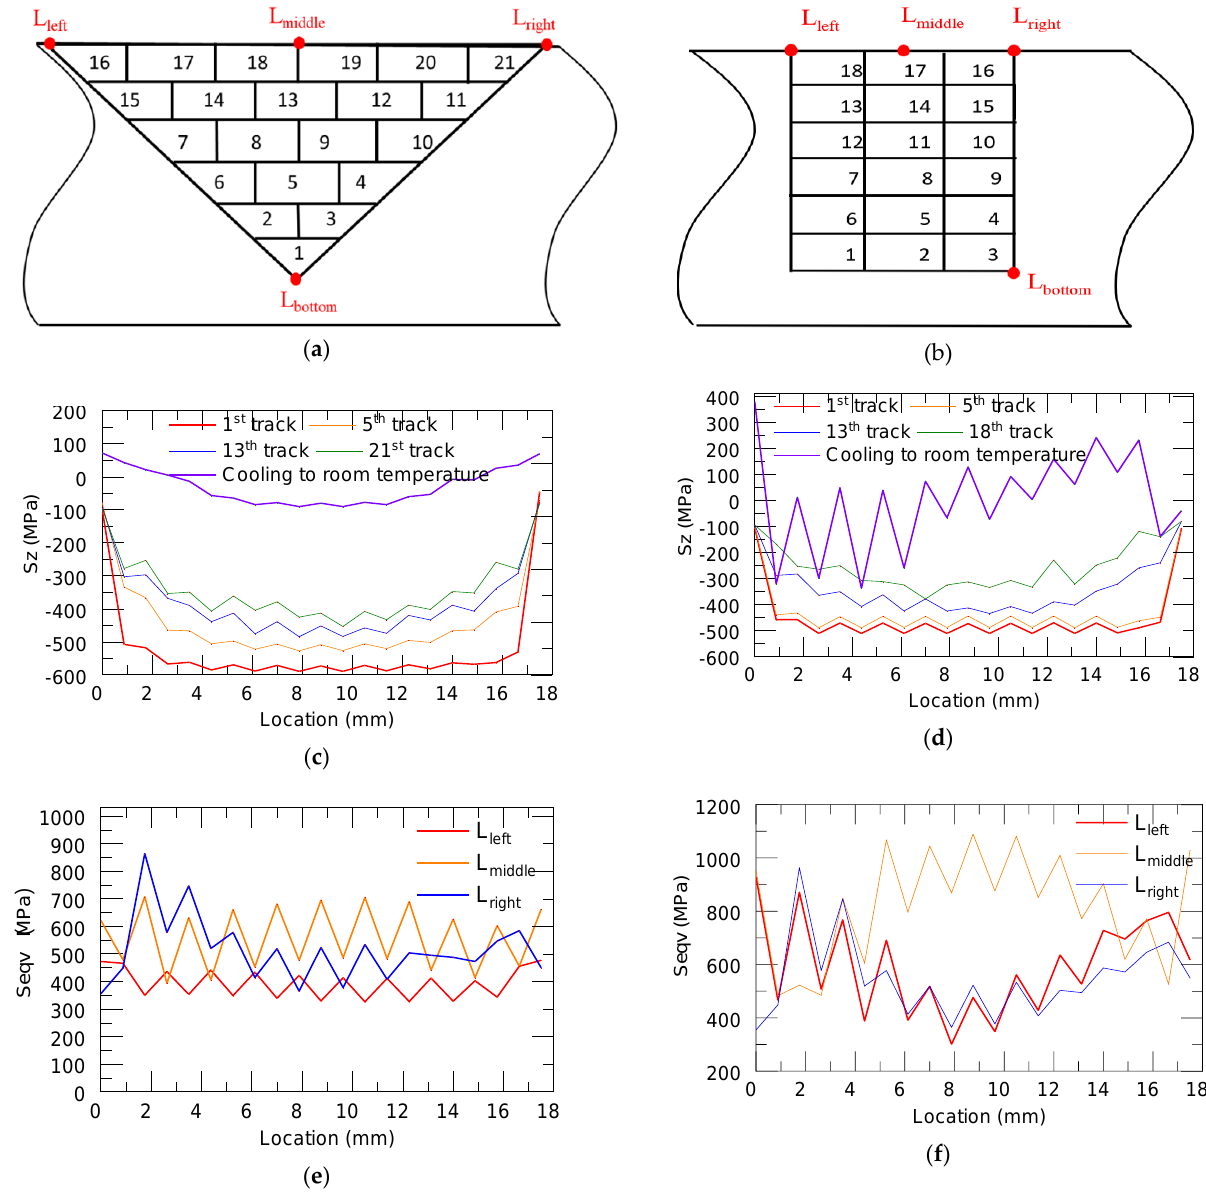
Figure 11. Schematic showing the definition of L left , L right , L middle , and L bottom for the triangular ( a ) and rectangular ( b ) case; longitudinal residual stress distribution along the interface line after the deposition of 1 st , 5 th , 13 th , and last layers in the triangular ( c ) and rectangular ( d ) repair cases; Von Mises stress distributions along three lines in the triangular ( e ) and rectangular ( f ) repair cases.